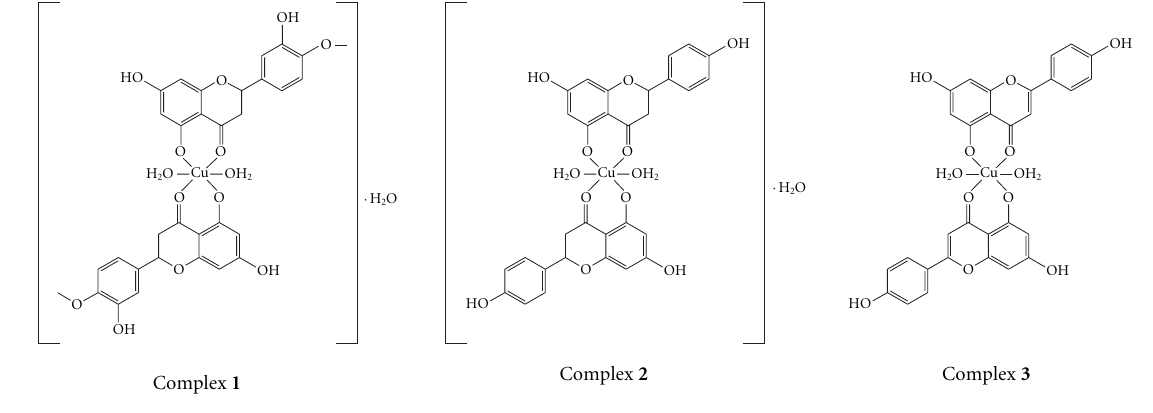
Scheme 2: The possible structures of the Cu(II) complexes.